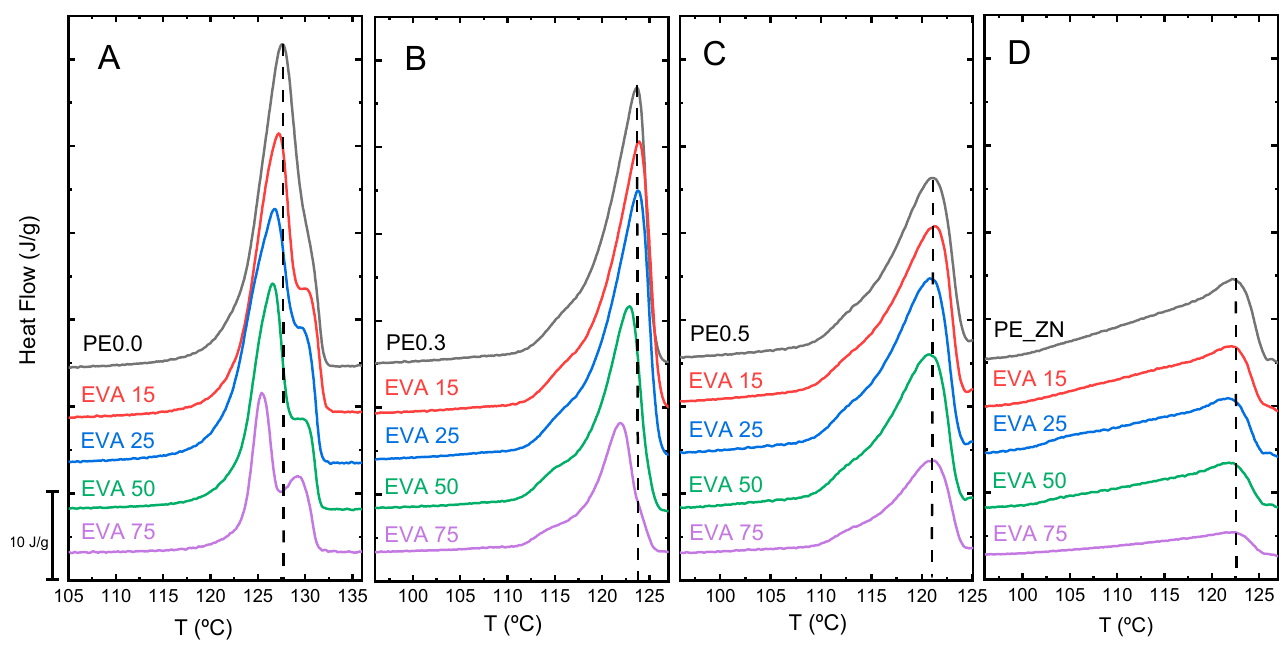
Figure 5. DSC melting traces of PE0.0 ( A ), PE0.3 ( B ), PE0.5 ( C ) and PE_ZN ( D ) single crystals mixtures with EVA in the whole compositional range.